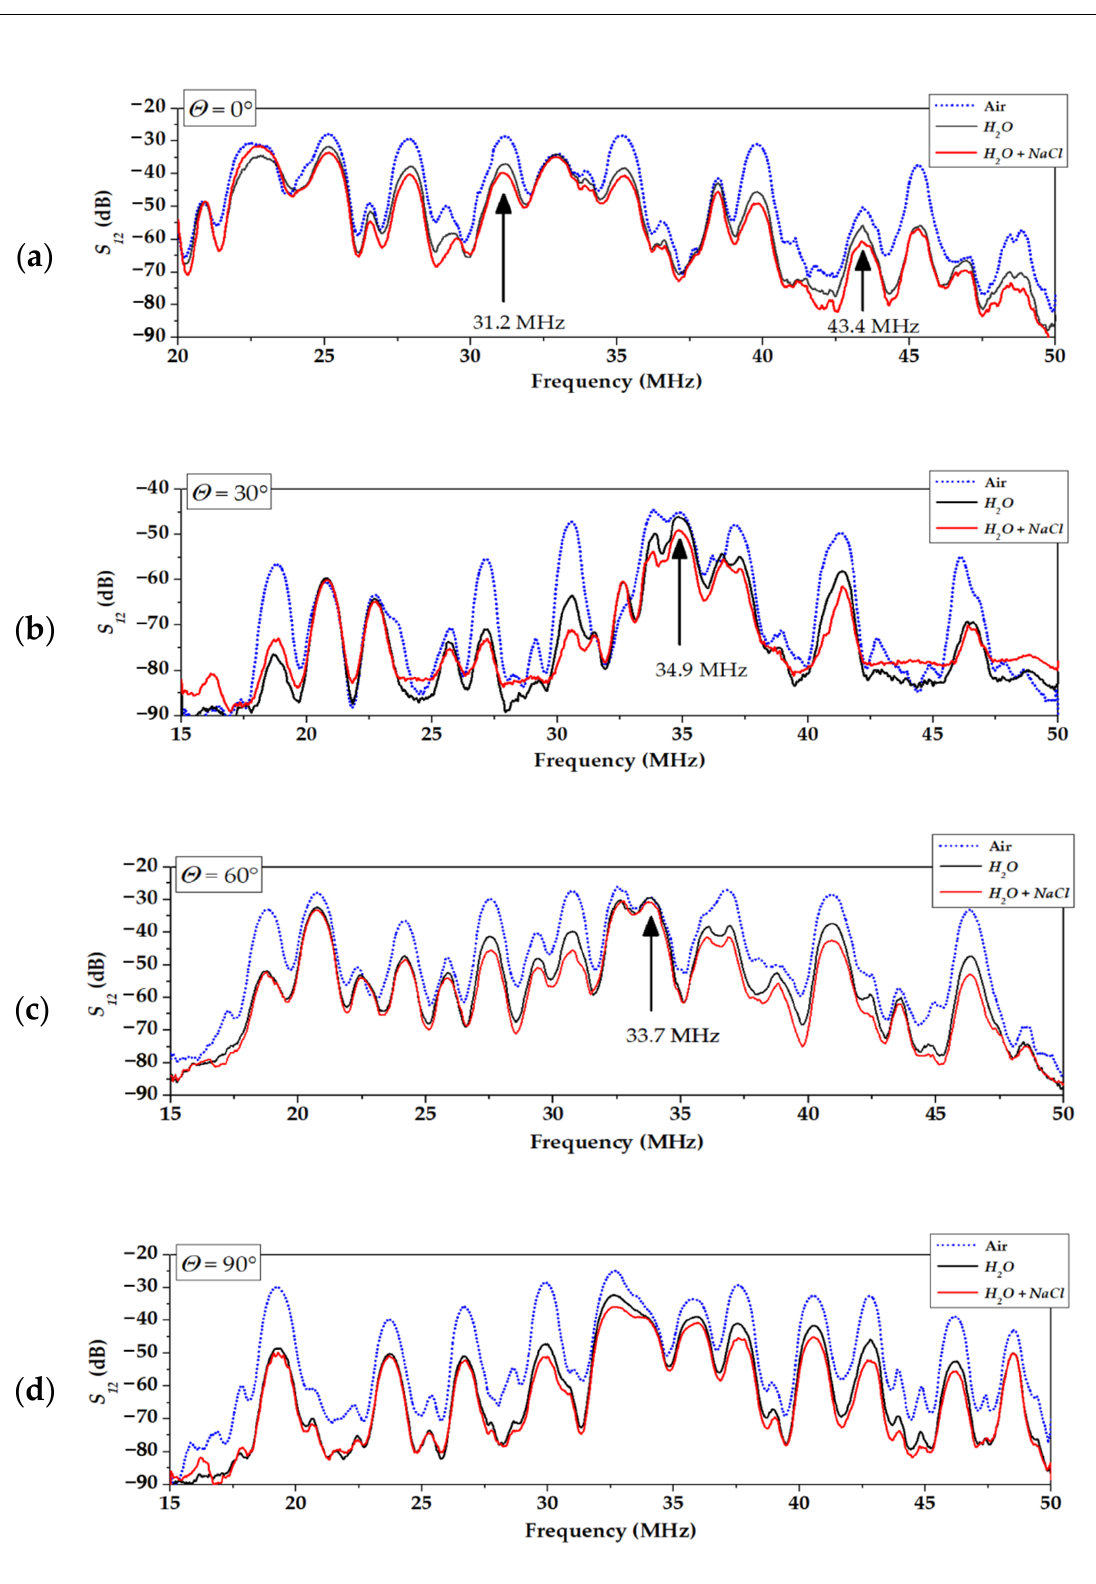
Figure 6. Insertion loss S 12 of the delay lines with different propagation directions measured for various loadings on the path (L = 18 mm). Plate: 128 ◦ Y- LiNbO 3 , h / λ = 1.75 ( h = 350 µ m, λ = 200 µ m). Propagation directions: Θ = 0 ◦ ( a ), 30 ◦ ( b ), 60 ◦ ( c ), and 90 ◦ ( d ) off X axis. Loadings: dashed lines correspond to case absence any liquid (AIR); black lines correspond to situation with presence of distilled water ( σ = 0 S/m, 200 mg); red lines correspond to situation with presence of NaCl water solution ( σ = 6 S/m, 200 mg). Bold arrows correspond to the modes with largest sensitivity towards liquid conductivity for each propagation